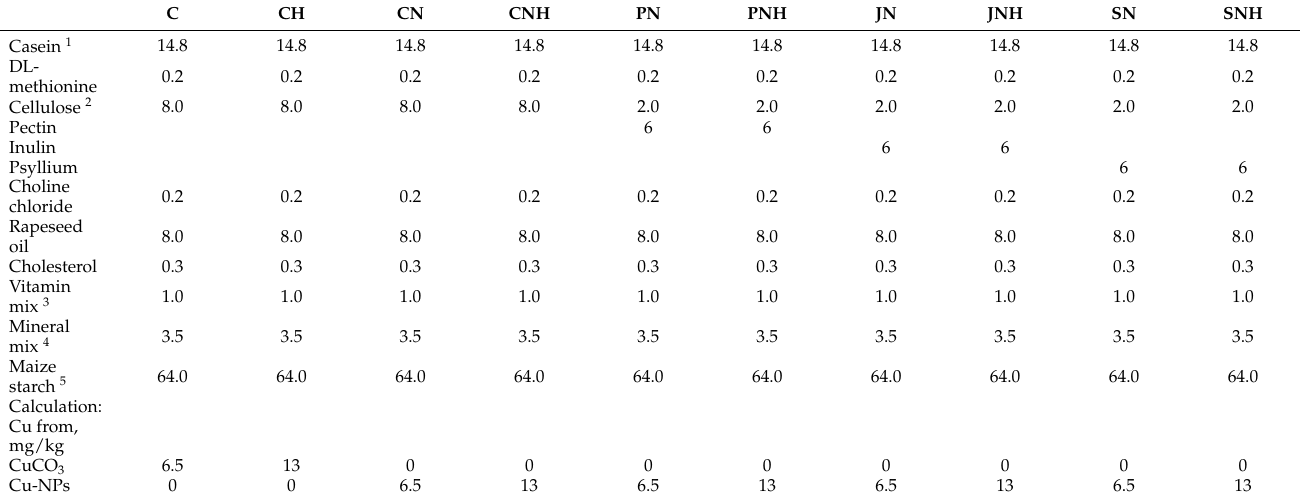
Table 1. The composition of experimental diets administered to rats for 6